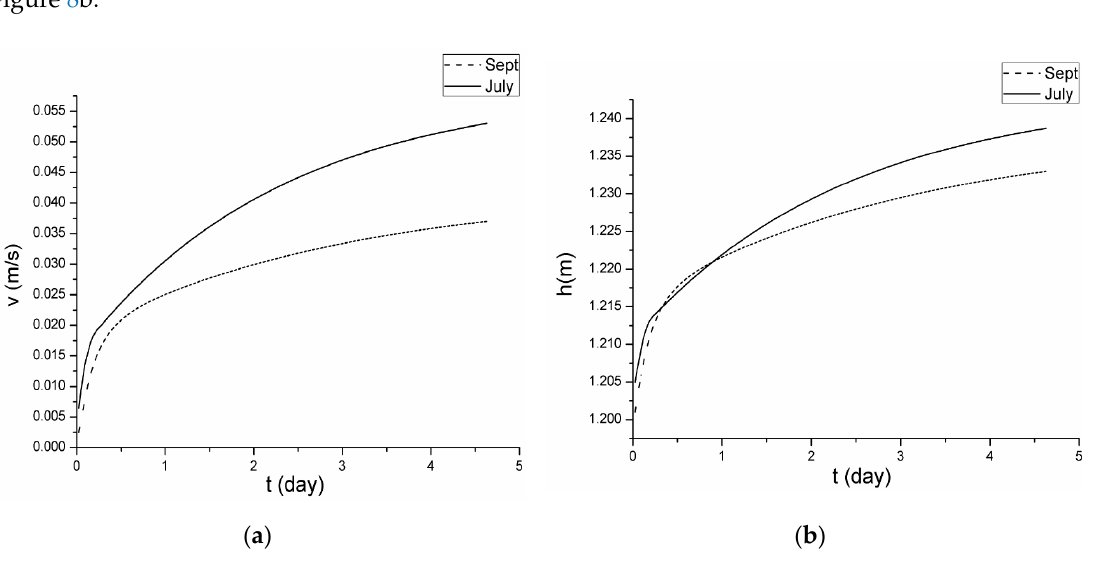
Figure 8. Comparison of the simulated results with different initial conditions: ( a ) Case 1 (water velocity); ( b ) Case 2 (water depth).